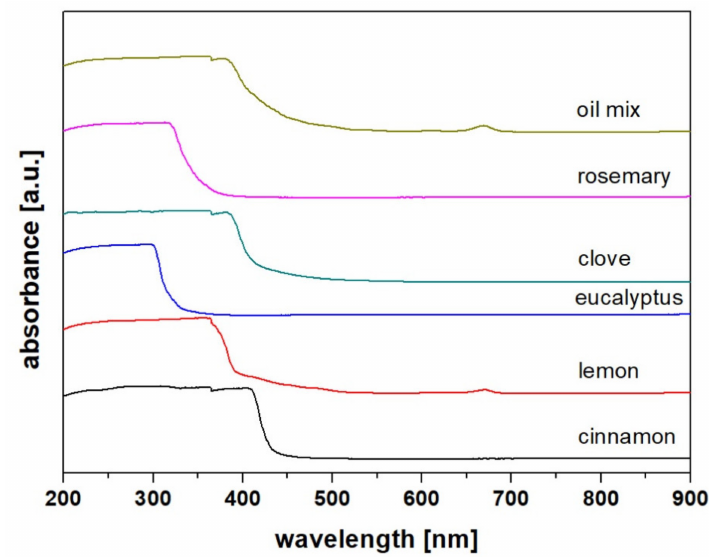
Figure 2. UV–vis spectra of the examined